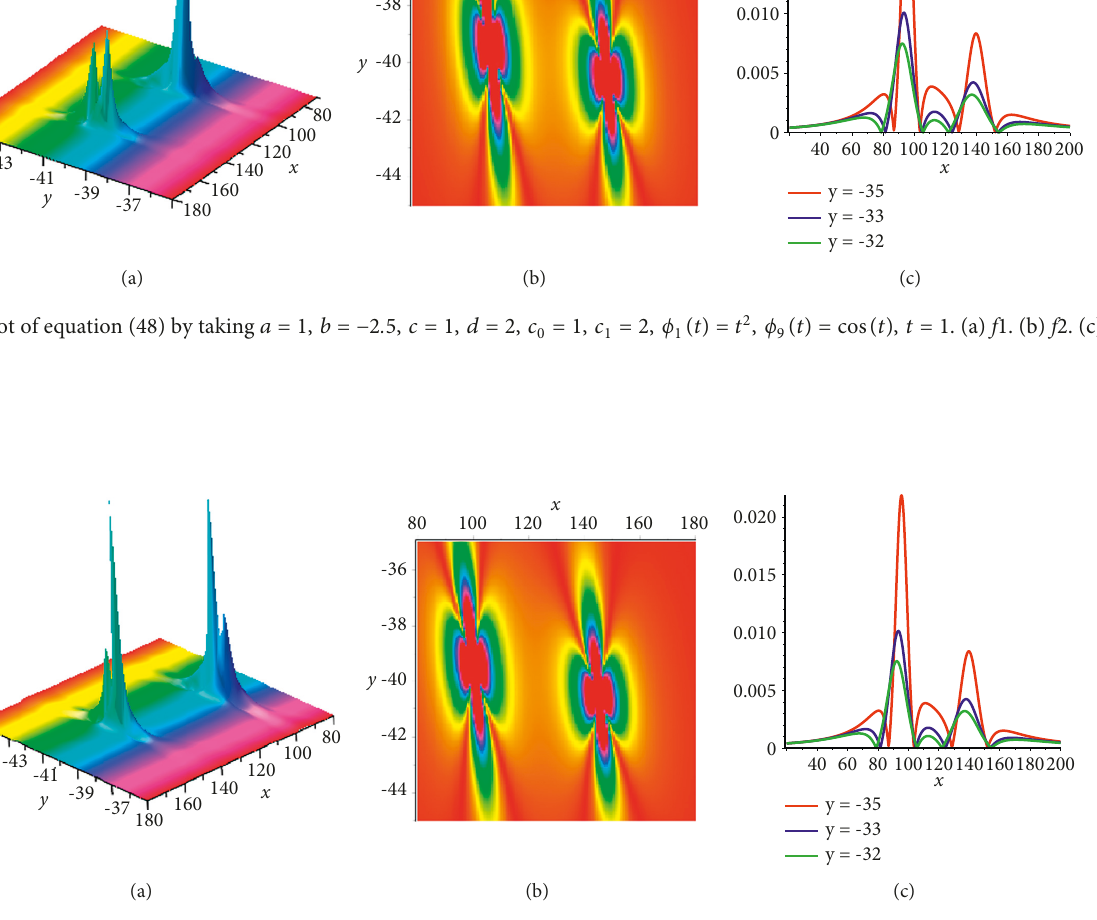
( t ) � t 3 , ϕ ( t ) � t + t 2 , t � 1. (a) f 1. (b) f 2. (c) f 1 9